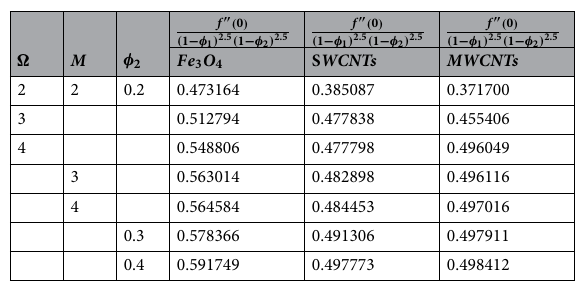
Table 3. The numerical outcomes for skin friction ( 1 − φ 1 ) 2.5 ( 1 − φ 2 ) 2.5 f ′′ ( 0 ) when φ 1 = φ 2 = 0.5, Pr = 6.2, N = 0.5 and M = 2.0.